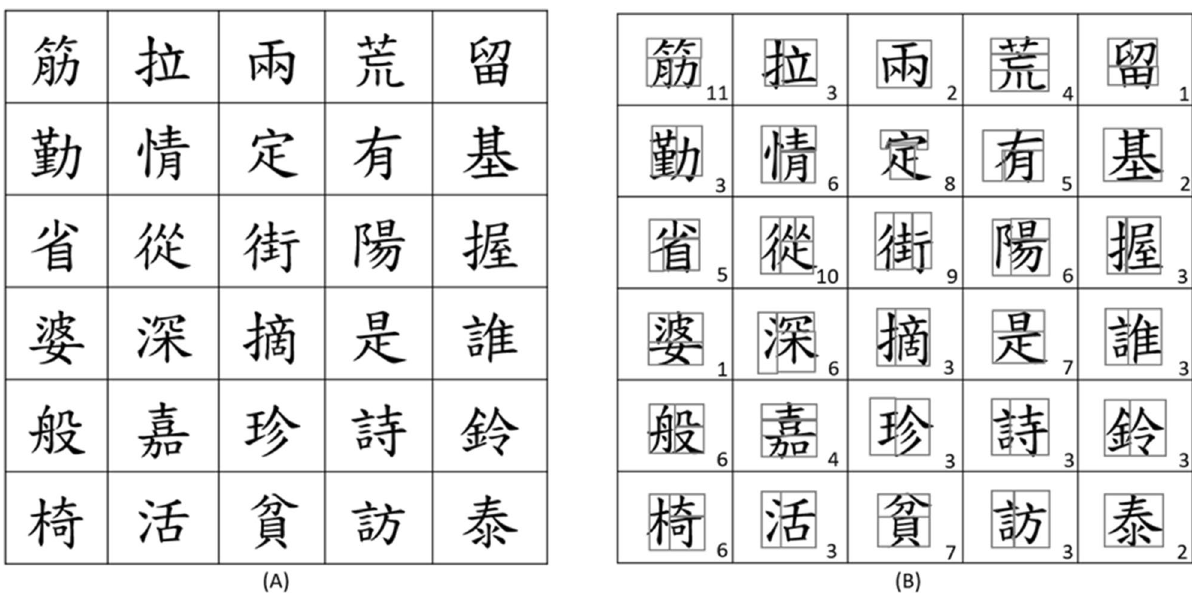
Figure 1. ( A ) The copying targets of Chinese characters. ( B ) The configuration of characters with segmented components.